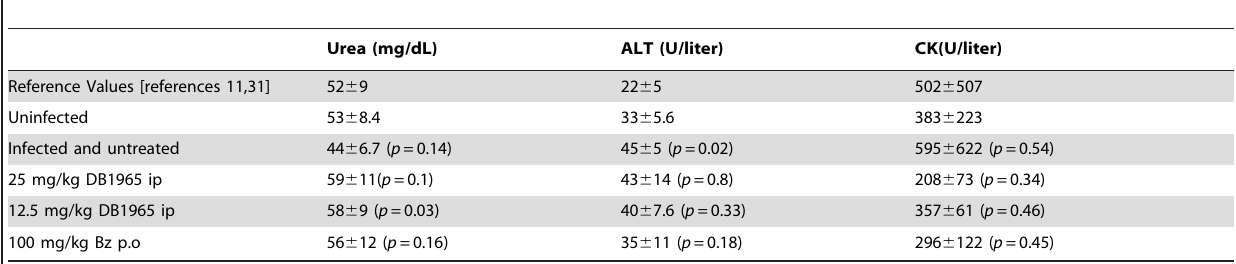
Table 3. Biochemical analysis of T.cruz i-infected mice treated or not by DB1965 and Benznidazole.